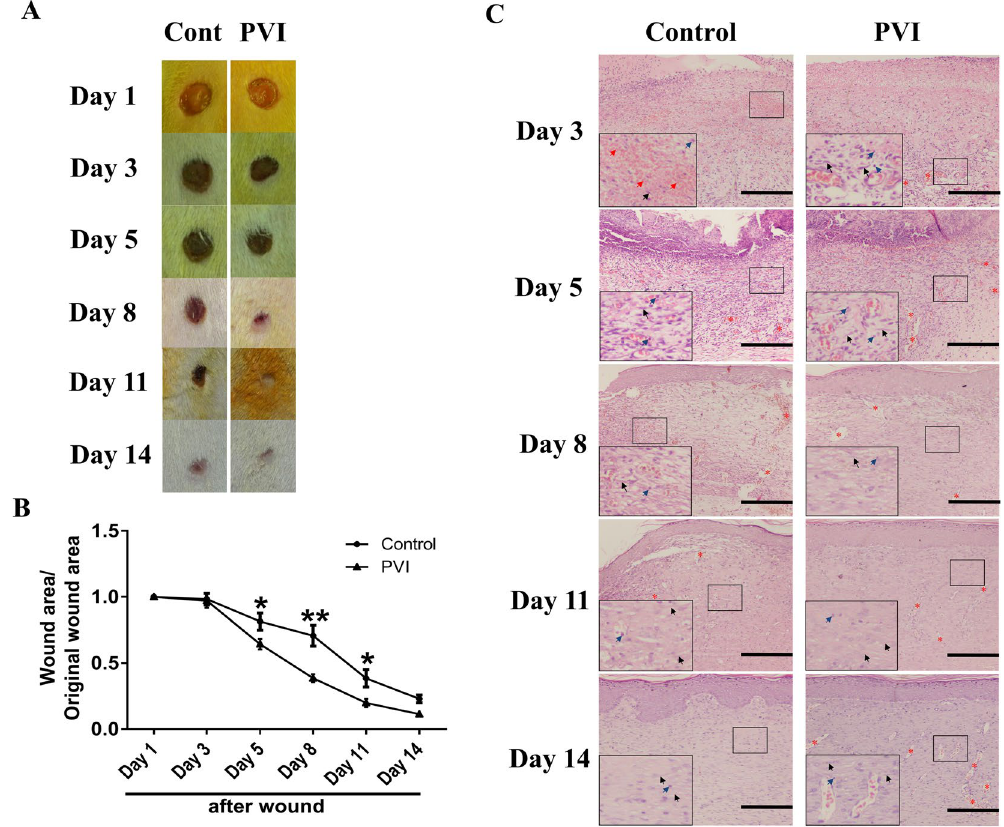
Figure 1. Povidone-iodine (PVI) treatment enhanced cutaneous wound closure and granulation tissue formation and maturation. ( A ) Representative photographs of wounds from a control and PVI treated rat. ( B ) Wound contraction (%) at day 1 to 14 post-injury. ( C ) Representative micrographs of H&E stained wound sections. Red arrows indicate red blood cells. Blue arrows indicate inflammatory cells. Grey arrows indicate fibroblasts. Red asterisks indicate new blood vessels. Scale bar = 50 μ m. * p < 0.05, ** p < 0.01 vs control. Data are means ± S.D, n =